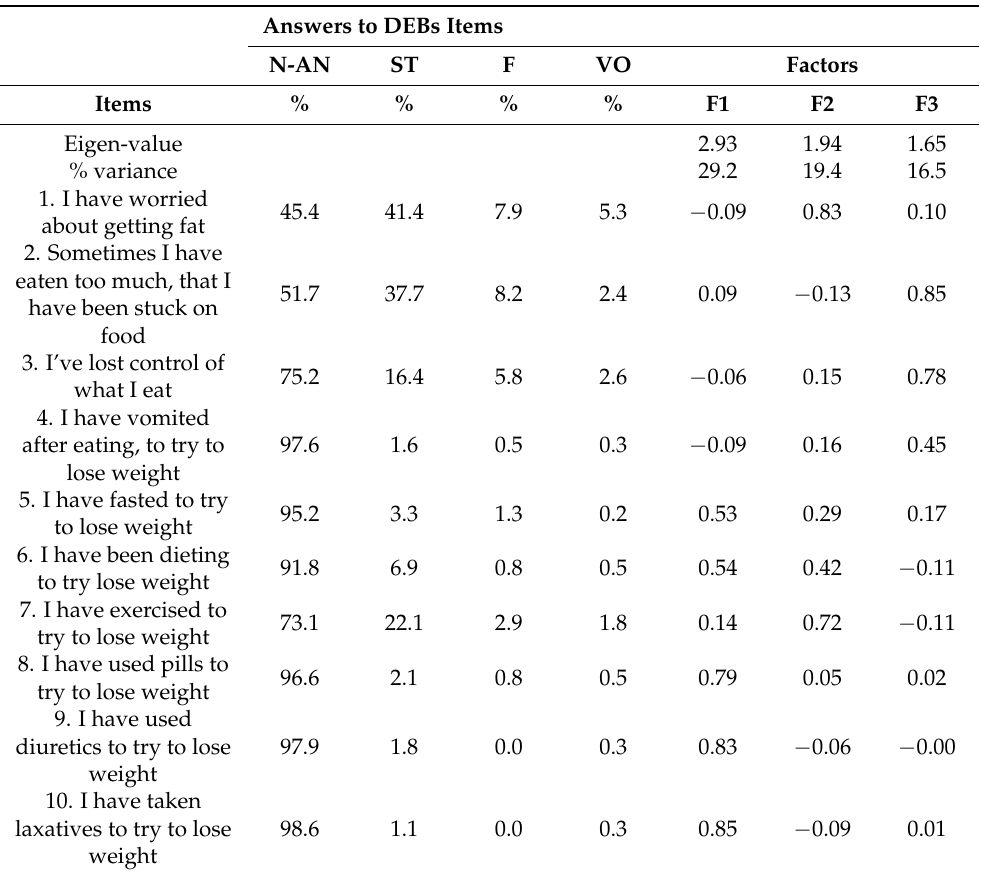
Table 1. Items and factorial analysis of the disordered eating behaviors inventory in a sample of Mexican adolescent pregnant women ( n = 379). Answers to DEBs Items N-AN ST VO